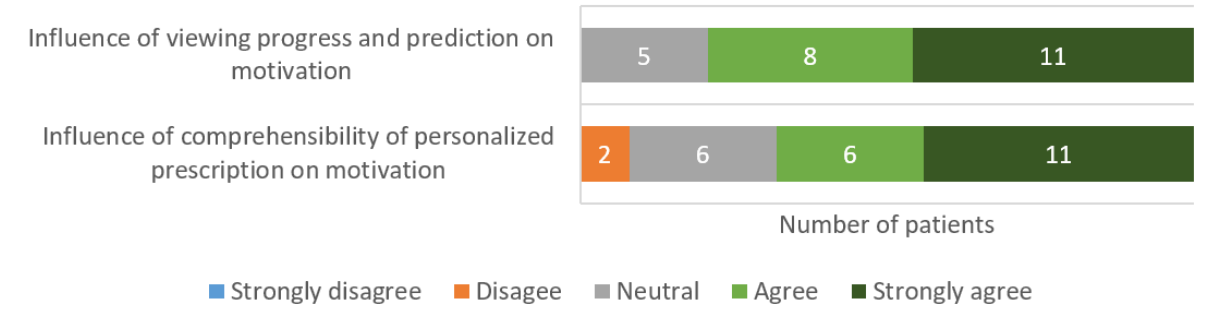
Figure 8. Patients' perceptions on the impact of HeartHab on motivation to achieve physical activity targets as collected in the intermediate questionnaire.